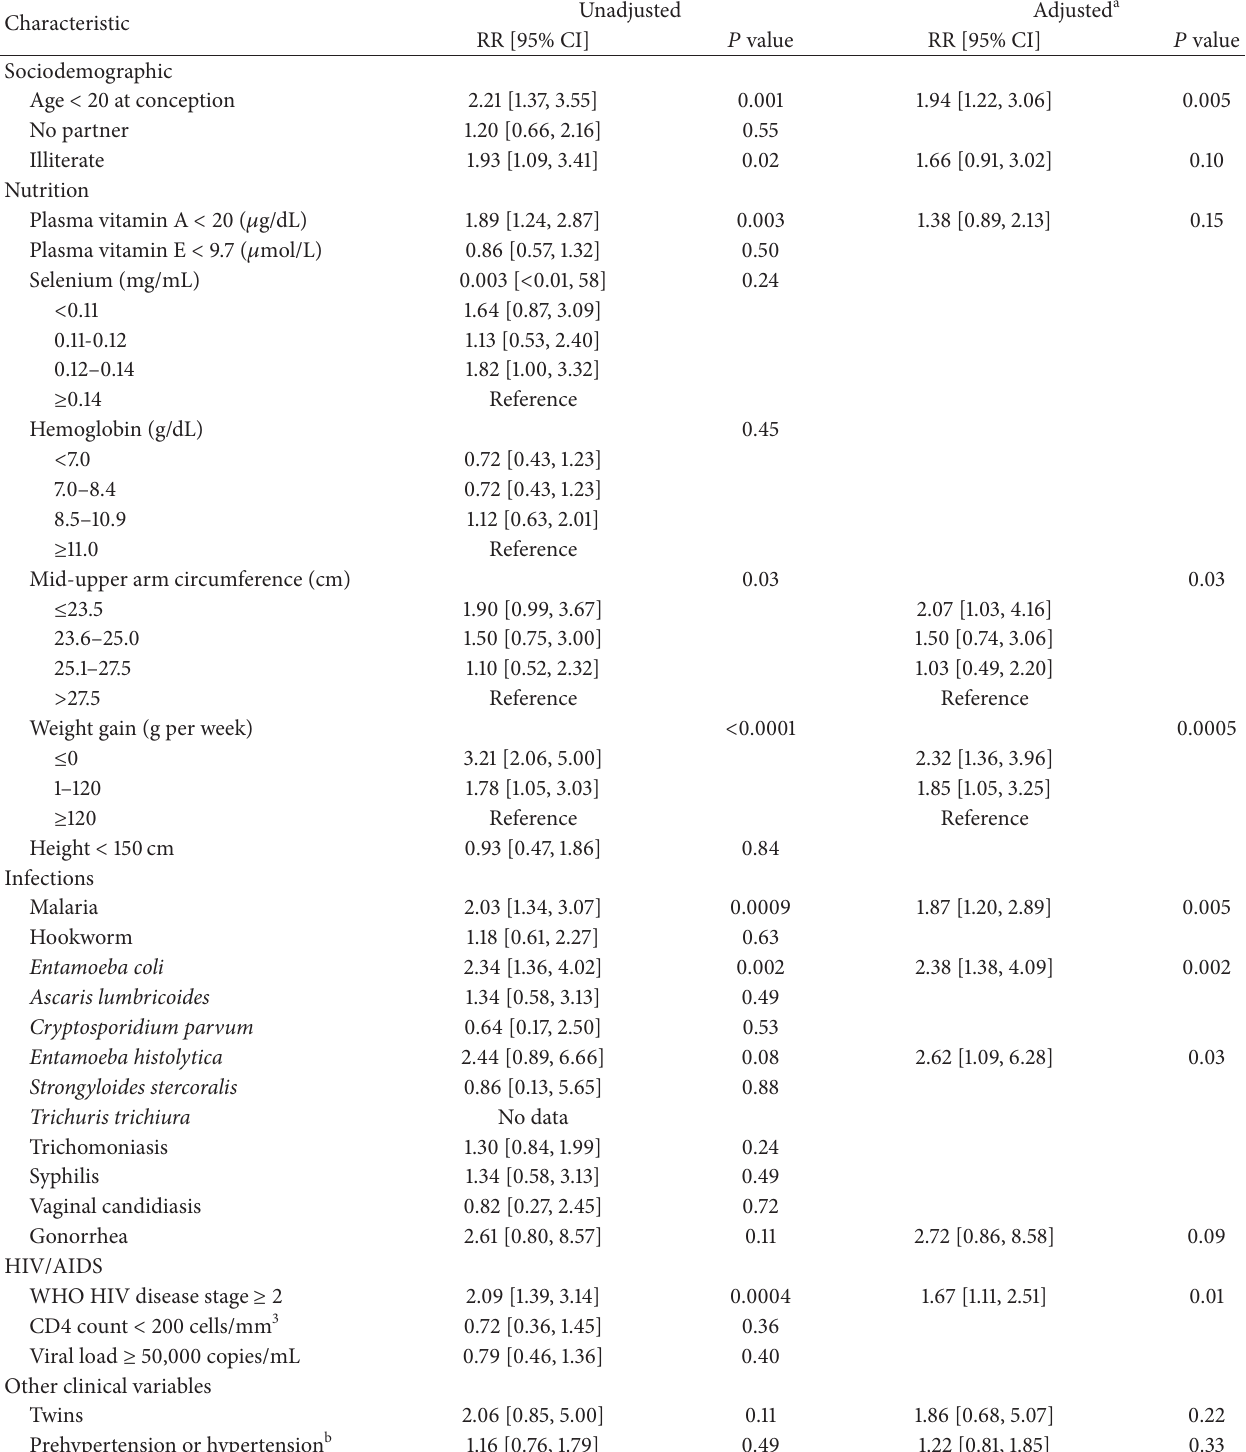
Table 3: Risk factors for very preterm birth ( < 34 weeks versus ≥ 37 weeks), 𝑁 = 787